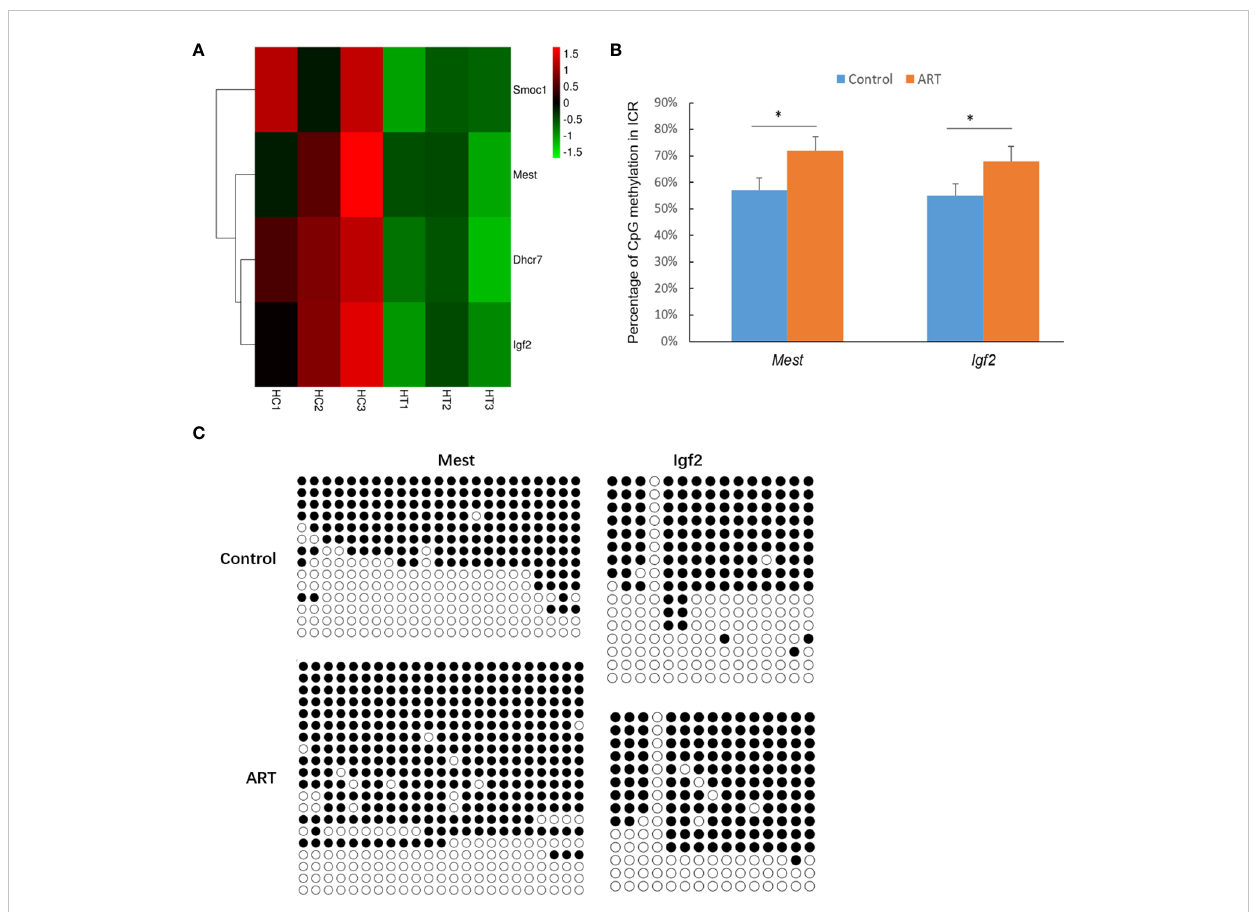
FIGURE 6 ART affects the expression and methylation of several imprinted genes in offspring hearts. (A) Imprinted genes with abnormal expression in heart tissue of ART offspring; (B) DNA methylation levels in imprinting control regions (ICRs) were detected by bisul fi te sequencing PCR (BSP) method; (C) representative results of methylation of imprinted genes Mest and Igf2 . Methylated and unmethylated CpG dinucleotides are represented by fi lled and open circles, respectively. Superscript “ * ” indicates signi fi cant difference between groups ( p <